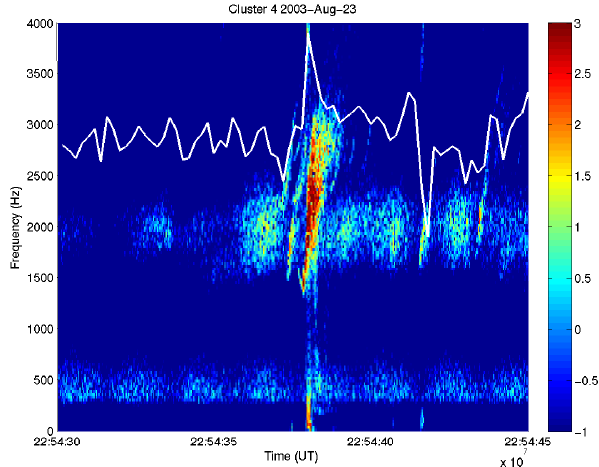
Fig. 2. Dynamic wave spectra and spacecraft potential plotted in the same format as Fig. 1 for the period